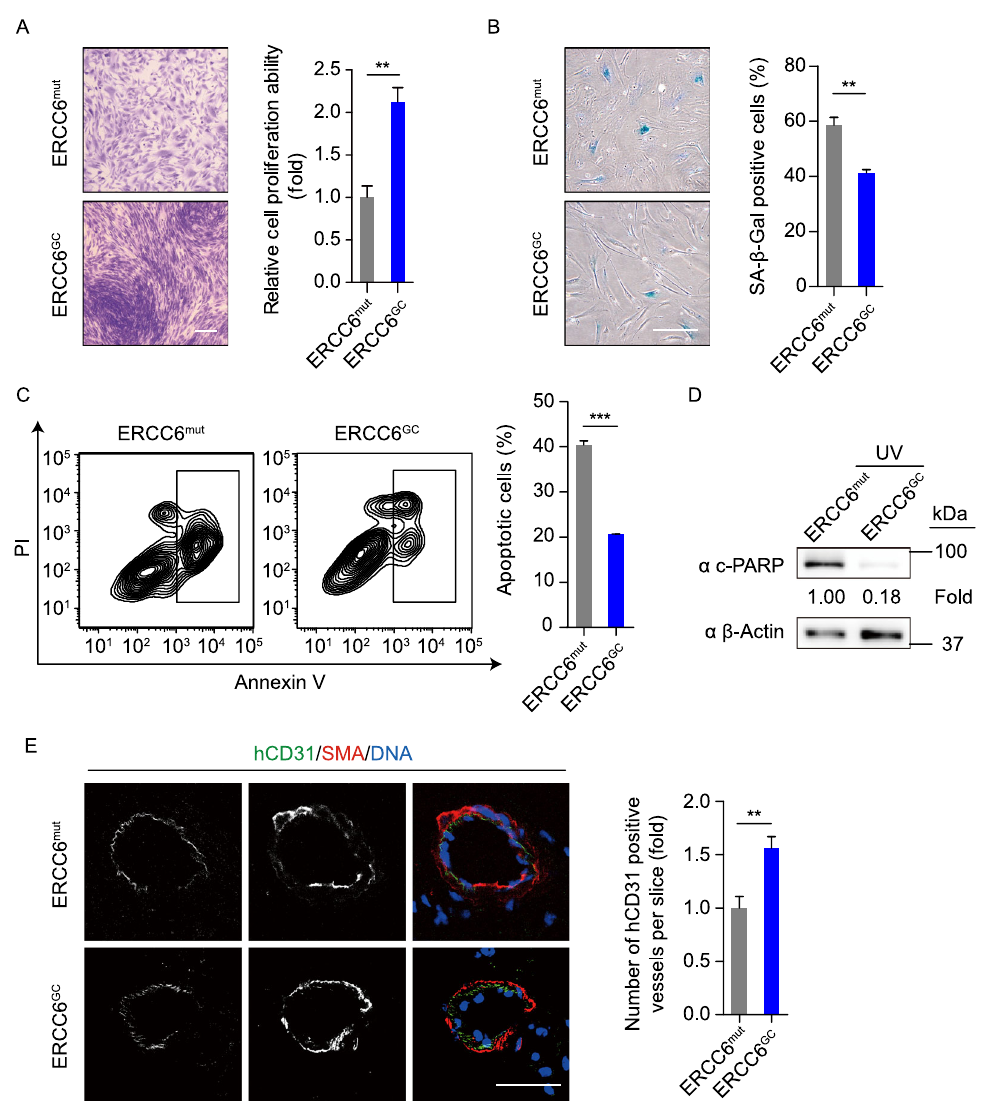
Figure 8. Gene-corrected CS-MSCs generated under a cGMP-compliant condition displayed alleviated aging defects and decreased susceptibility to UV-induced apoptosis. (A) Clonal expansion assay showing the cell proliferation ability of CS-MSCs and GC-MSCs. The cells were stained with crystal violet after a two-week culture, and the relative intensity of the crystal violet was quanti fi ed. Data are presented as the mean ± SEM, n = 4, ** P < 0.01. Scale bar, 50 μ m. (B) SA- β -Gal staining of CS-MSCs and GC- MSCs. The percentages of SA- β -Gal-positive cells are shown in the right panel. Data are presented as the mean ± SEM, n = 3, ** P < 0.01. Scale bar, 50 μ m. (C) Apoptosis analysis of CS-MSCs and GC-MSCs 48 h after 10 J/m 2 UV irradiation. Quantitative data are presented as the mean ± SEM, n = 3, *** P < 0.001. (D) Western blots showing PARP cleavage of CS-MSCs and GC-MSCs in the presence of 10 J/m 2 UV exposure. β -Actin was used as a loading control. (E) Fat pad transplantation with CS-MSCs and GC-MSCs. Left: representative immuno fl uorescent images showing neovascularization; right: the number of hCD31-positive vessels calculated based on 24 slices from inconsecutive frozen sections. Data are presented as the mean ± SD, n = 3 for each group, ** P < 0.01. Scale bar, 50 μ